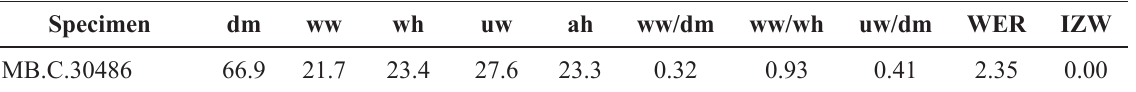
Table 17. Conch dimensions (in mm) and ratios of Maccoyoceras concavum sp. nov.